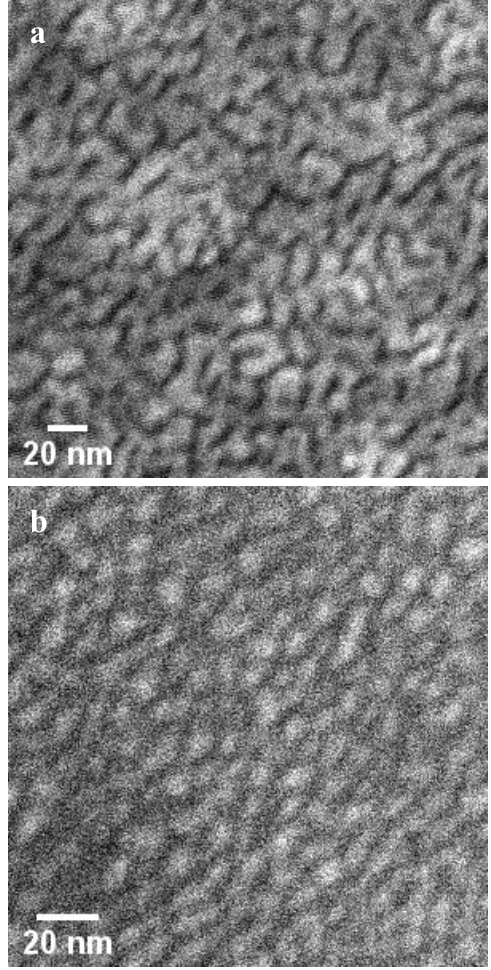
Figure 1. SiO 2 (54 at.% Co)/Si ( a ) and SiO 2 (82 at.% Co)/Si ( b ) images in the secondary electron mode with the InLens detector, mounted above the films. Light contrast corresponds to the SiO 2 matrix and dark areas correspond to Co